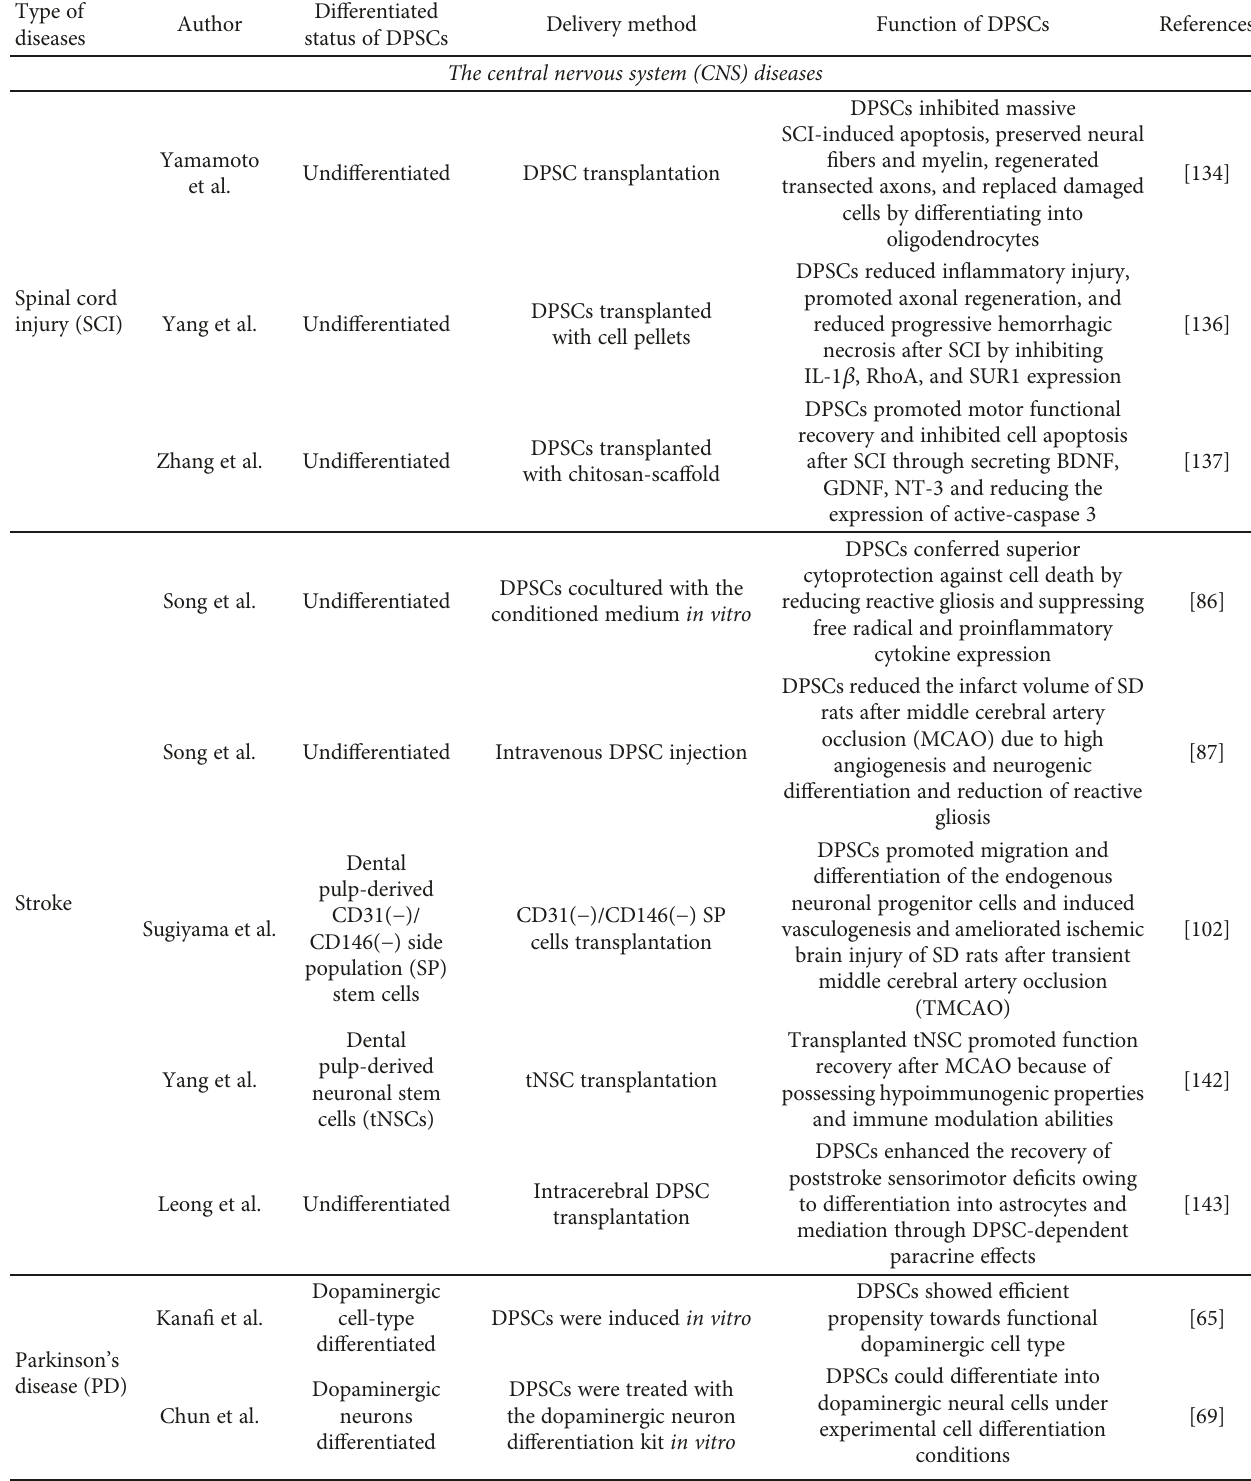
Table 1: Examples for the bene fi cial of DPSCs on the central nervous system (CNS) diseases and the peripheral nervous system (PNS)